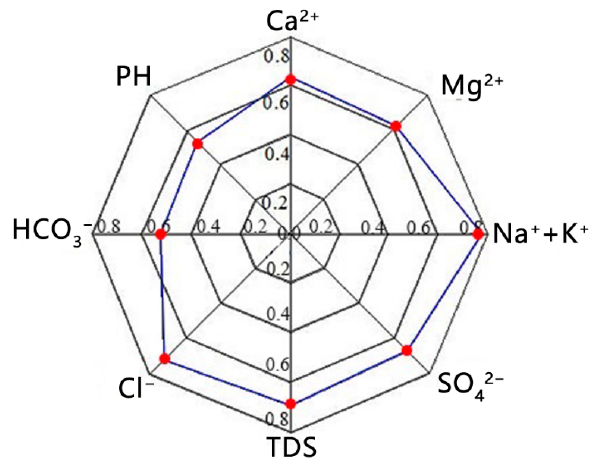
Figure 12. Gray correlation image between soil salinity content and groundwater. (b) Correlation of soil salinity at different depths and